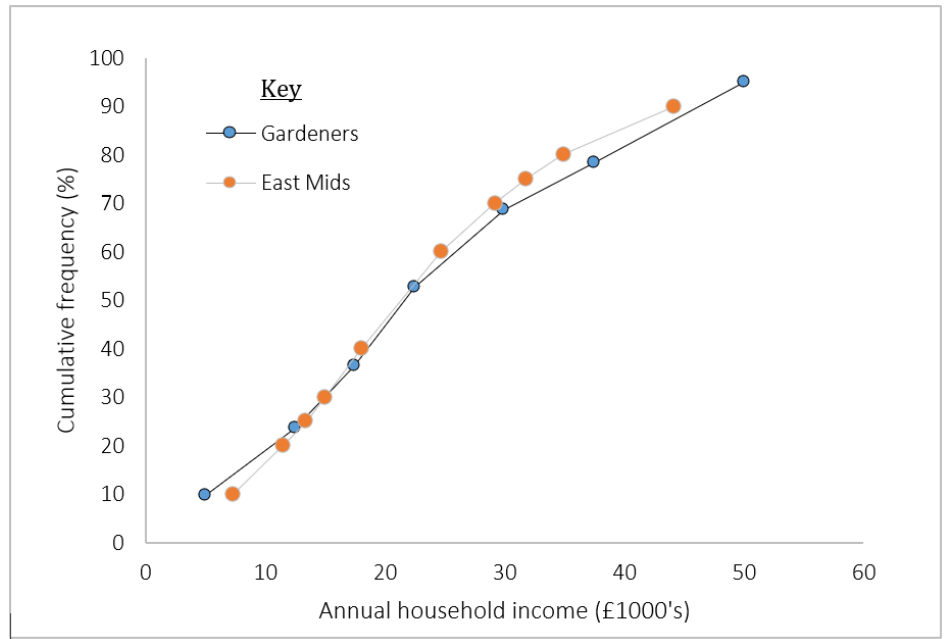
Figure 1. Comparison of annual household income (AHI) reported by participants in the gardening and health survey (gardeners), with estimated AHI from the East Midlands (ONS, 2017). Annual household income for gardeners was calculated using the mid-point of the categories over which AHI was assessed in question D18 from the questionnaire (Supplementary Materials).